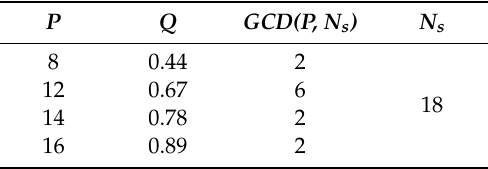
Table 4. Modeled rotor poles